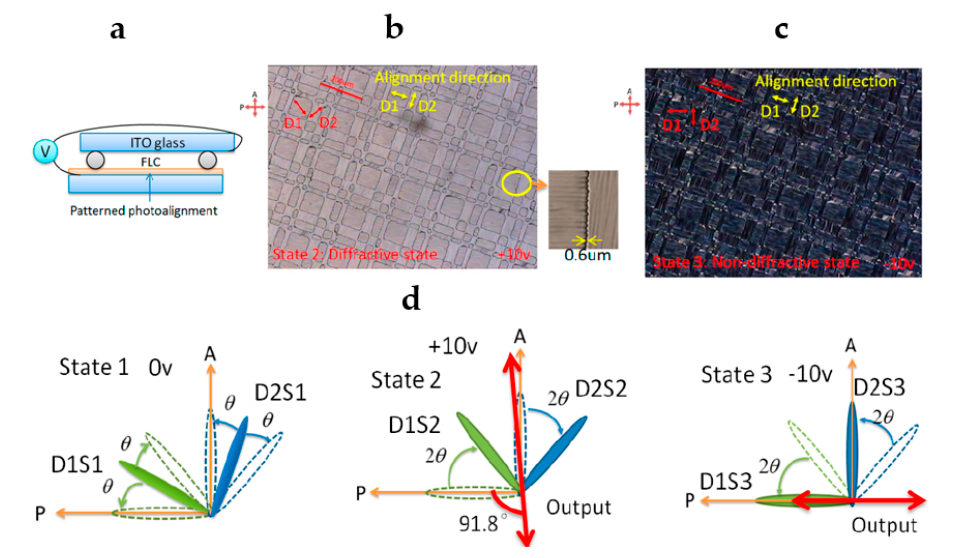
Figure 11. ( a ) Structure of the FLC Dammann grating; ( b ) diffractive state under crossed polarizer and analyzer (microscopic photo); ( c ) microscopic photo of the electrically suppressed helix (ESH) FLC Dammann grating (DG) in the non-diffractive state under crossed polarizer and analyzer; ( d ) illustration of molecular orientation and the output polarization plane in different states for two types of domains [67].